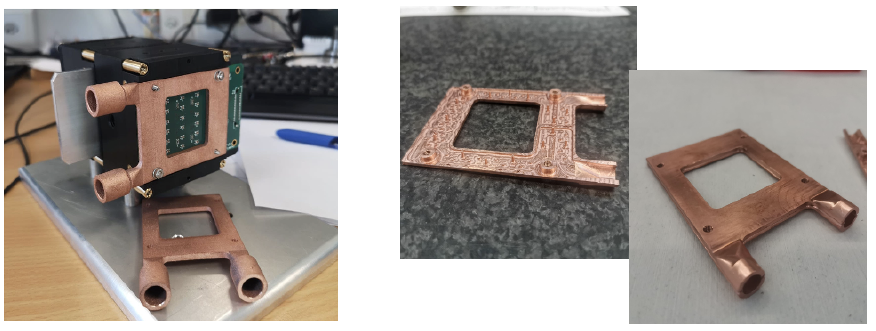
Figure 3. For comparison the cooling exchangers have been realized at CERN in 3D metal printer technology ( left ) and at the mechanical workshop of Sezione of Ferrara of INFN with the Computer Numerical Control (CNC) milling machine ( right